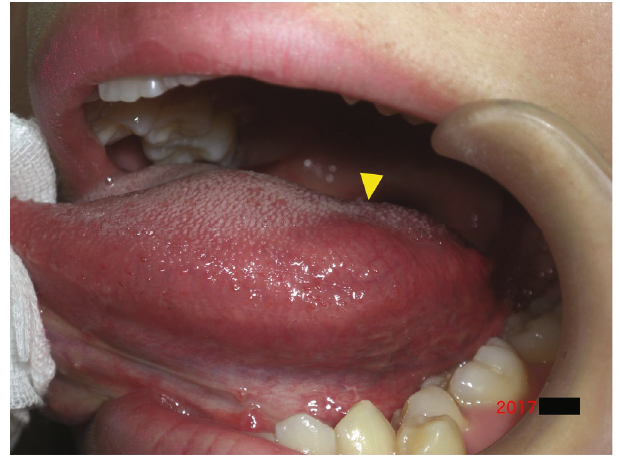
Figure 1: Intraoral photograph showing an elastic soft mass measuring 10 mm in diameter in the left tongue (arrowhead). The overlying mucosa is normal.